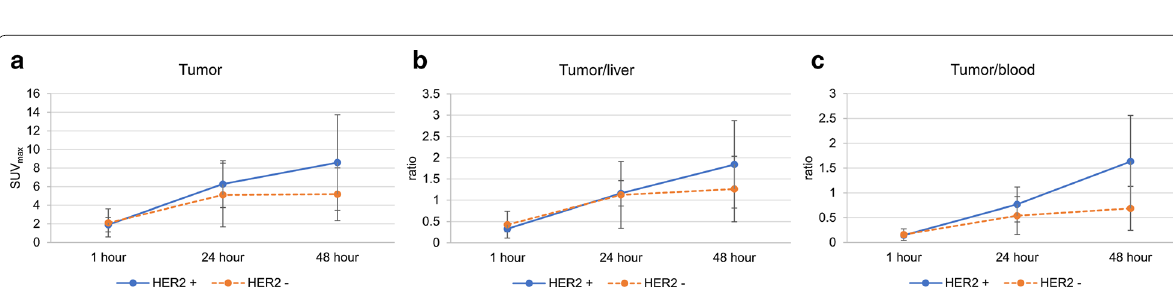
Fig. 3 Maximum intensity projection images of 64 Cu‑NOTA‑Trastuzumab PET at 1, 24, and 48 h after injection